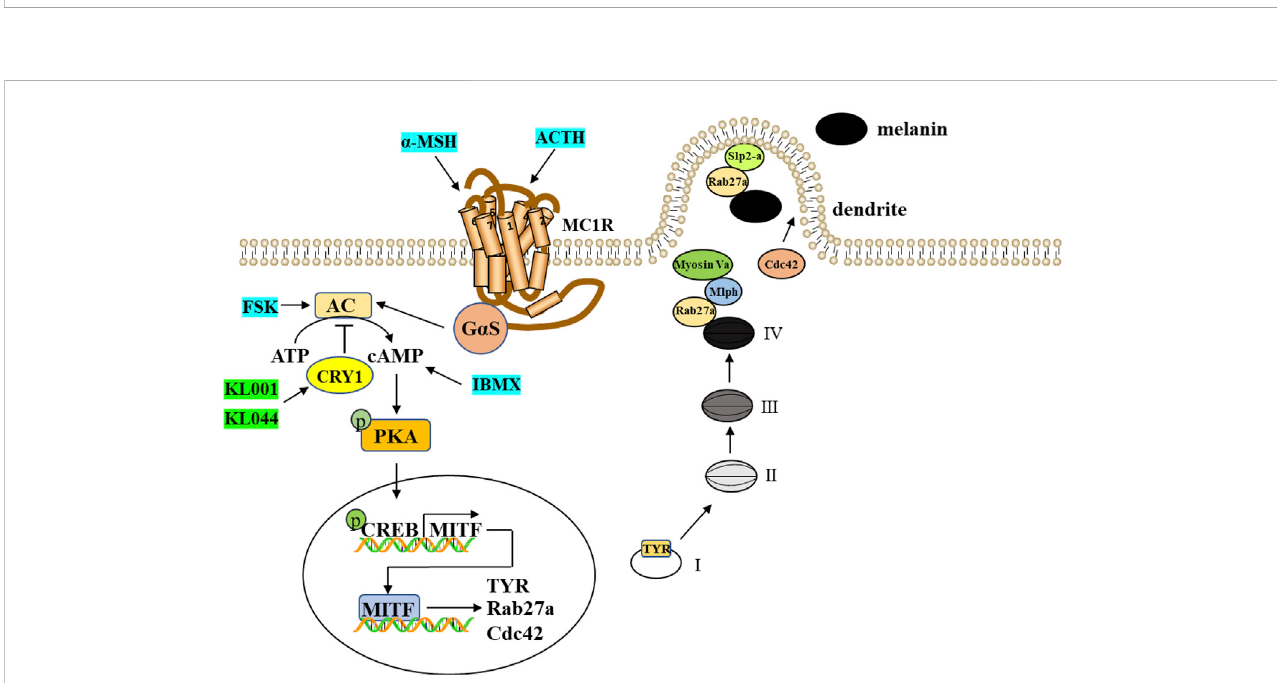
FIGURE 8 A proposed scheme shows that CRY1 activation inhibits melanogenesis and melanosome transport through negative regulation of cAMP/PKA/CREB signaling pathway. cAMP-mediated expression of MITF induces the expression of TYR, Cdc42, and Rab27a, thereby driving melanosome maturation and transport. TYR is a critical enzyme for the melanogenesis and Cdc42 contributes to dendrite extension and fi lopodia formation. Rab27a interacts with two Rab27a effectors, Mlph and Slp2-a, and thereby regulates actin-dependent melanosome transport and melanosome anchoring to the plasma membrane,